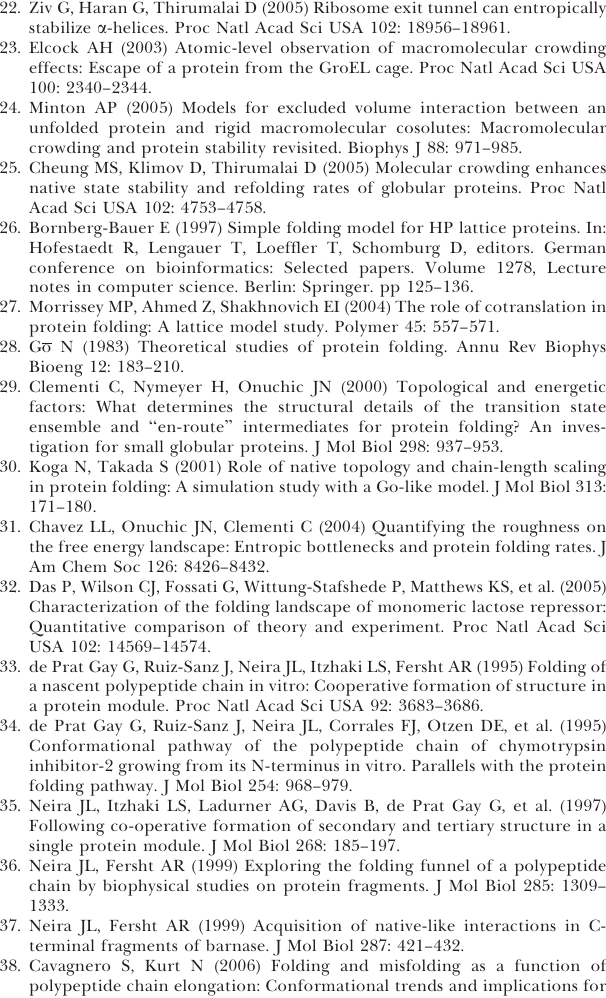
obtained using r ij ¼ 4.0 A˚ for protein–ribosome interactions; error bars indicate the standard deviation of values obtained from 30 independent trajectories. (B) Same as (A), but filled symbols indicate results obtained with r ij ¼ 4.5 A˚ ; open symbols again refer to de novo folding in the absence of the ribosome. (C) Same as (B), but with r ij ¼ 5.0 A˚ . (D) Same as (B), but with r ij ¼ 5.5 A˚ . (E) Same as (B), but with r ij ¼ 6.0 A˚ . (F) Same as (B), but with r ij ¼ 4.0 A˚ and an attractive potential of well depth e ¼ 0.1 kcal/mol. (G) Same as (F), but with an attractive Figure S12. Effect of Altering the Interaction between the Nascent Protein and the Ribosome on the De Novo Folding Mechanism in Coupled Synthesis–Folding Simulations of CI2